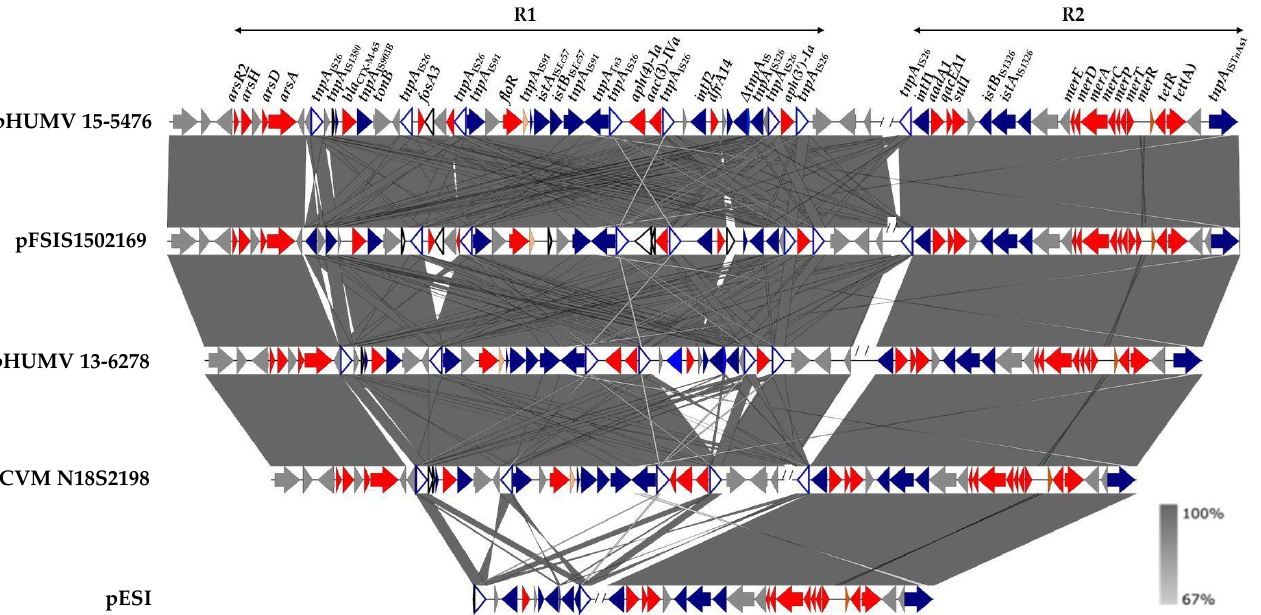
Figure 1. Comparison between the assembled resistance regions (R1 and R2) of the pESI-like plasmids pHUMV 13-6278 and pHUMV 15-5476 found in the Salmonella enterica serovar Infantis isolates under study with related regions from other pESI-like plasmids (accession No. CP016407, CP082522 and GCA_000506925.1 for plasmids of the FSIS1502169, CVM N18S2198 isolates and plasmid pES1 of the 119944 isolate, respectively). Coding regions are represented by arrows indicating the direction of transcription and colored according to their function: red, resistance; blue, insertion sequences, with the multiple copies of IS26 highlighted by arrowheads with white background and blue border lines; grey, other roles; white with black border lines, hypothetical proteins. The alignments were created with EasyFig BLASTn. The gray shading between regions reflects nucleotide sequence identities according to the scale shown at the right lower corner of the